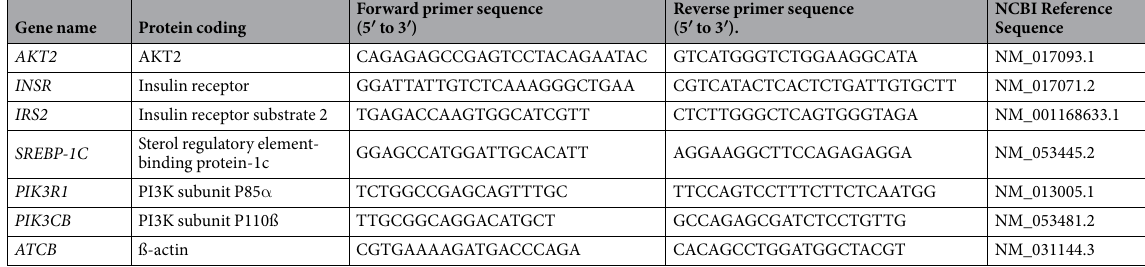
Table 2. Primer sequences used for determination of mRNA